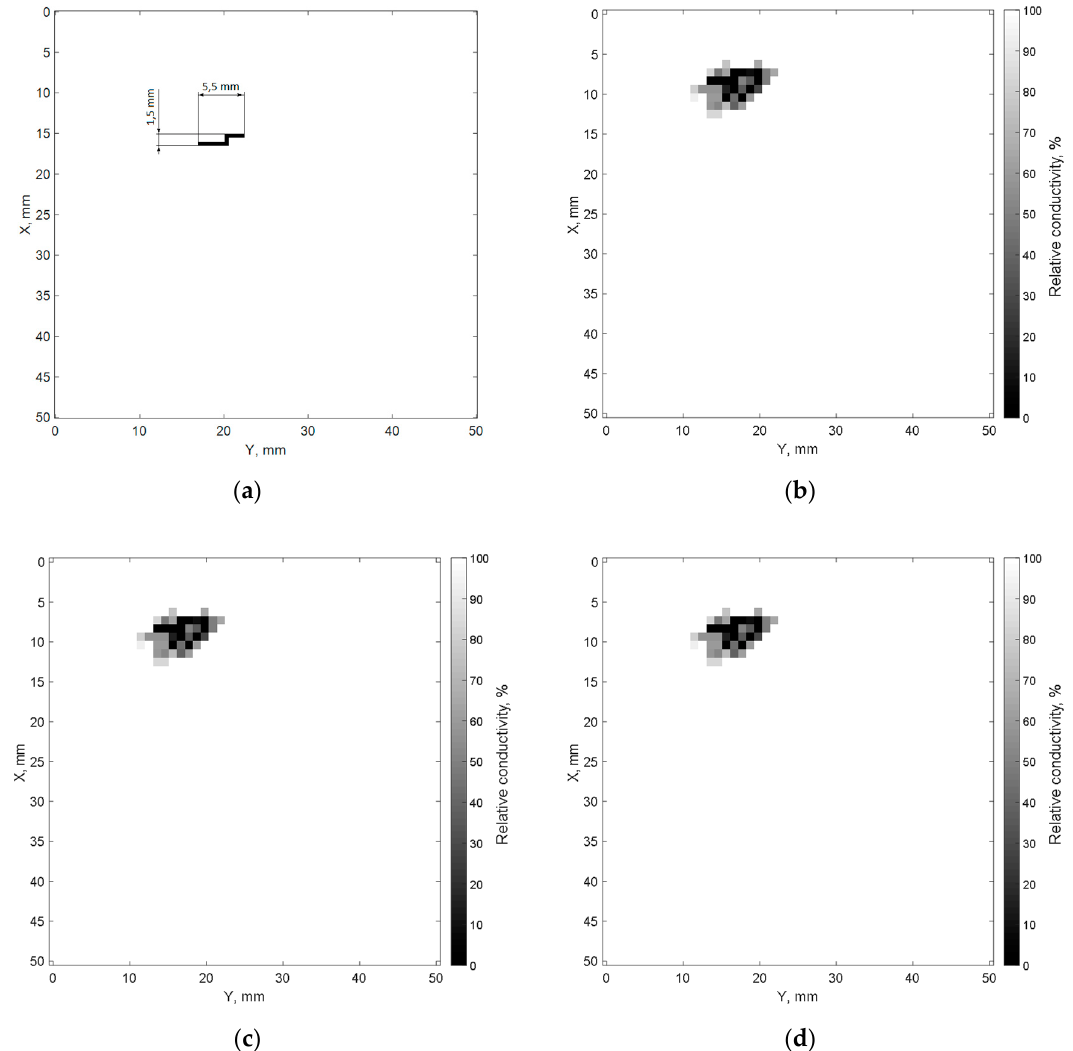
Figure 8. Results of imitative modeling of the process of crack ( a ) registration, obtained at a grid node number of 49 × 49, at the digital filter parameters γ = 1 × 10 4 , K F = 0.05, for the 16 contacts, for the initial sensor film conductivity of 8.93 × 10 5 S/m (nichrome) ( b ), 2.33 × 10 6 S/m (manganin) ( c ), and 1.82 × 10 7 S/m (tungsten) ( d ).